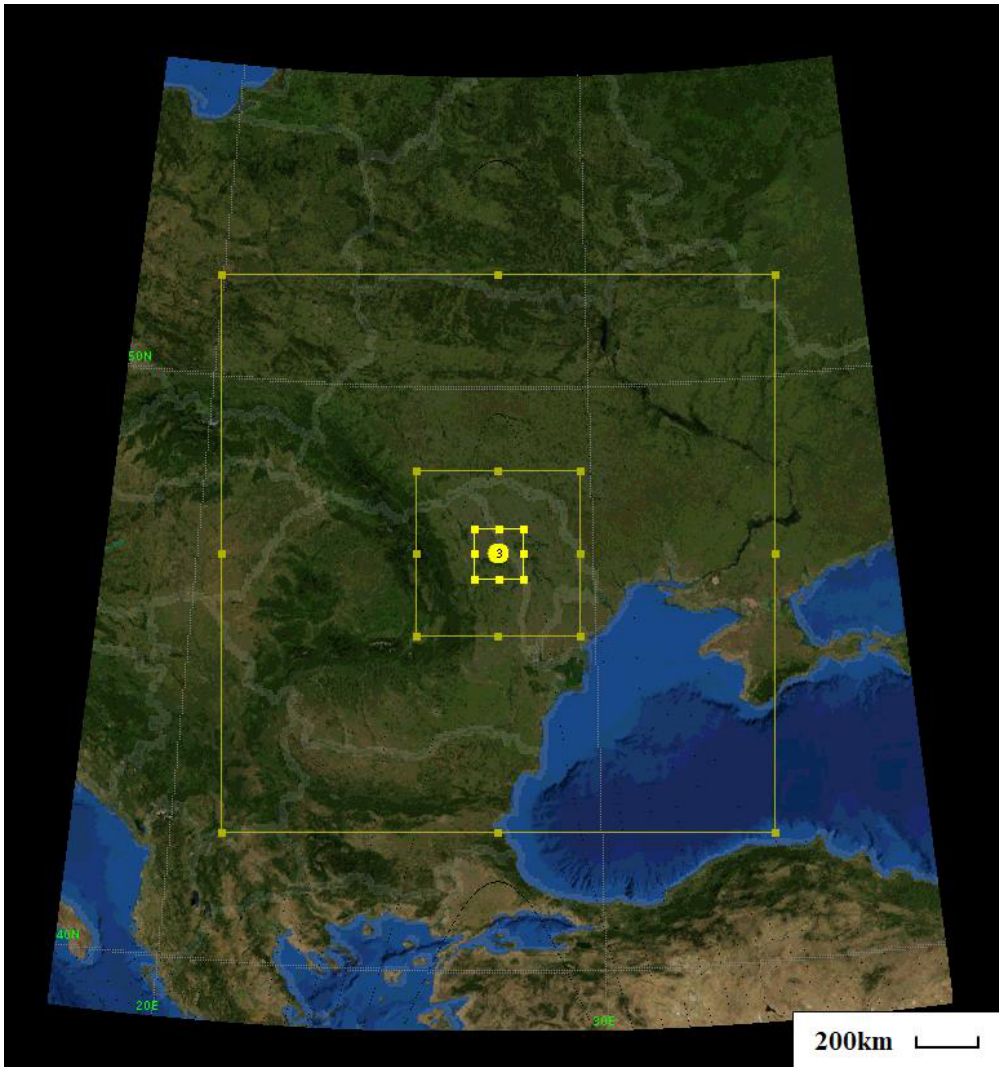
Figure 1. Three nested model domains used in this study (yellow lines). 1st nest: contains the entirety of Romania and Republic of Moldova, along with the area around it and sections of neighboring countries. 2nd nest: contains larger Moldova and Bucovina region of Romania, and the majority of the Republic of Moldova. 3rd nest: contains area around the city of Iași . Number 3 (in yellow circle) represents the city of Iași.